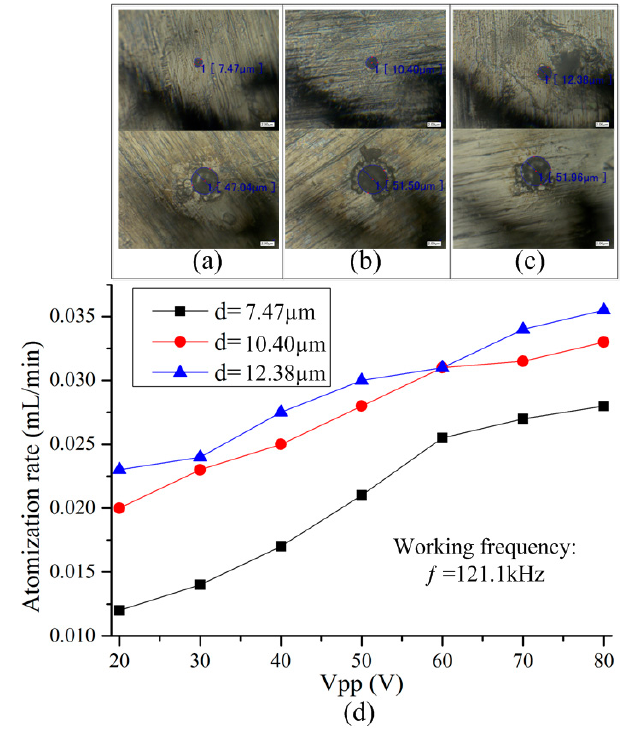
Figure 9. The relationship between the atomization rate and voltage for three micro-tapered aperture atomizers with different diameters. ( a ) Photographs of the micro-tapered holes with number 1; ( b ) Photographs of the micro-tapered holes with number 2; ( c ) Photographs of the micro-tapered holes with number 3; ( d ) The relationship between the atomization rate and voltage for three micro-tapered aperture atomizers with different diameters.